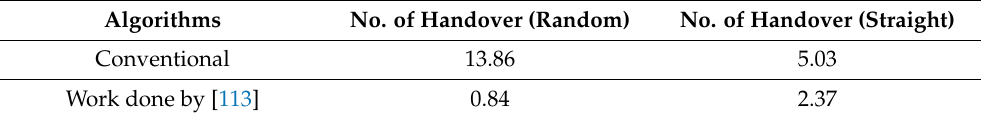
Table 2. Outcomes of the